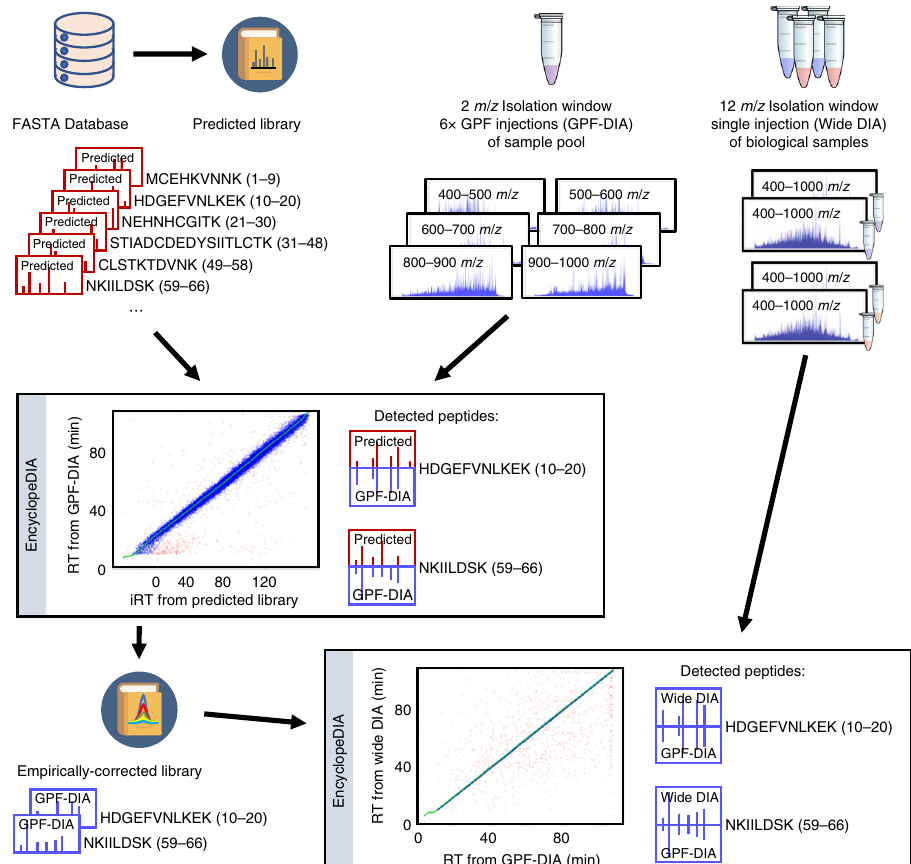
Fig. 1 Work fl ow for generating empirically corrected libraries. Fragmentation patterns and indexed retention times (iRTs) are generated with Prosit for all possible tryptic peptides in a FASTA database, and these predictions are compiled into a predicted spectrum library. In this example, peptides from CDPK2 are shown with start/stop indices within the protein indicated in parentheses (red predicted spectra). We use EncyclopeDIA to search GPF-DIA acquisitions of a sample pool with that library, and peptides detection results are compiled into a experiment-speci fi c, empirically corrected library. This new library contains fragmentation patterns and retention times extracted from the GPF-DIA data for only the detected peptides (blue empirical spectra). Since GPF-DIA and single-injection DIA have the same instrumentation and on-column matrix, retention times and fragmentation patterns in the empirically corrected library are more closely aligned than the original